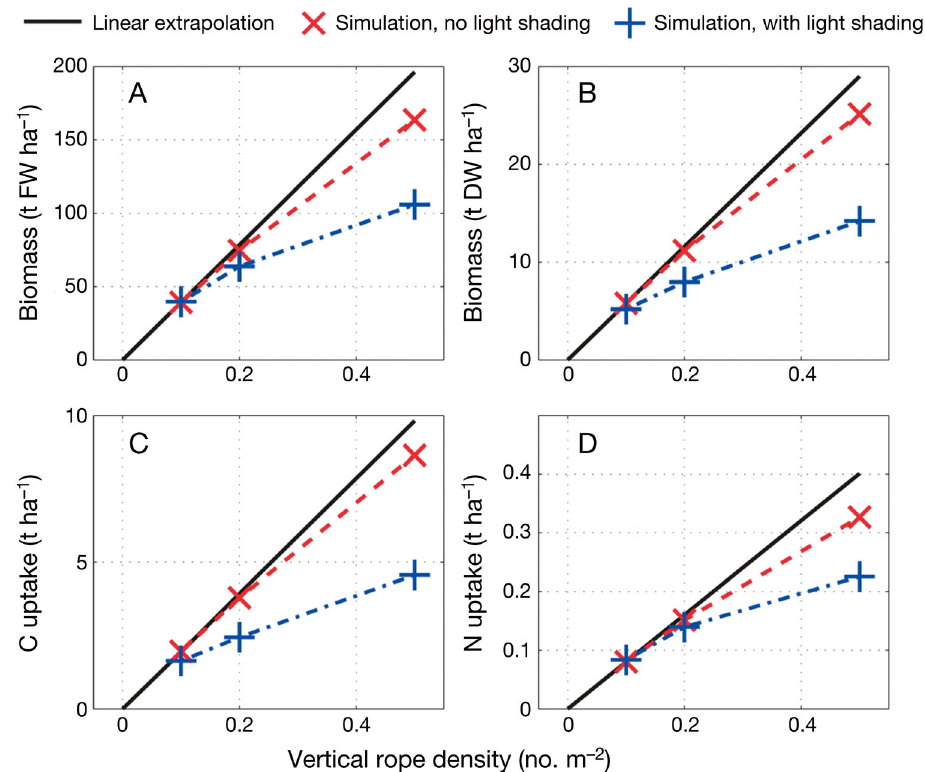
Fig. 17. Saccharina latissima . Comparisons of (A,B) biomass yields and (C) carbon and (D) nitrogen uptake estimated in 3 ways: (1) linear extrapolation of simulated values for a single 5 m long vertical rope (continuous black lines), (2) simulations with nutrient uptake by the kelp but no light shading (red crosses) and (3) simulations with nutrient uptake and light shading by the kelp (blue plus signs). In all cases the biomass was assumed to be harvested on 15 June, with deployment on 21 February. DW (FW): dry (fresh) weight